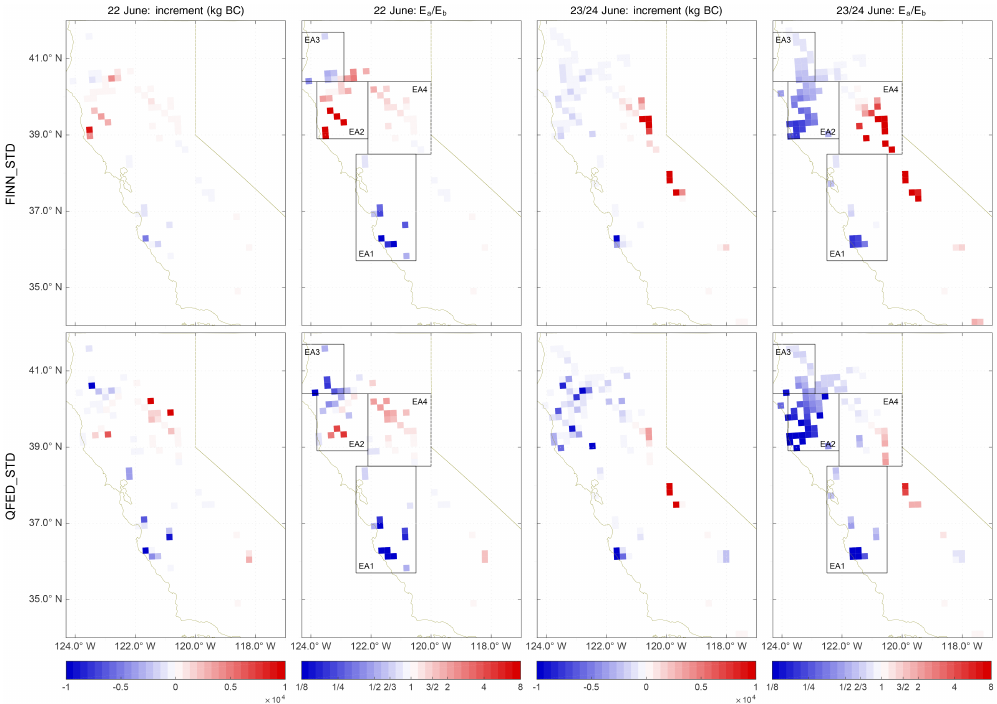
Figure 8. BB analysis increment (posterior minus prior) per 24h and posterior linear scaling factor ( β ) for the two primary BB scenarios on 22 June 00:00–23:00Z and 23 June 00:00Z–24 June 23:00Z. EA1–4 are outlined with black